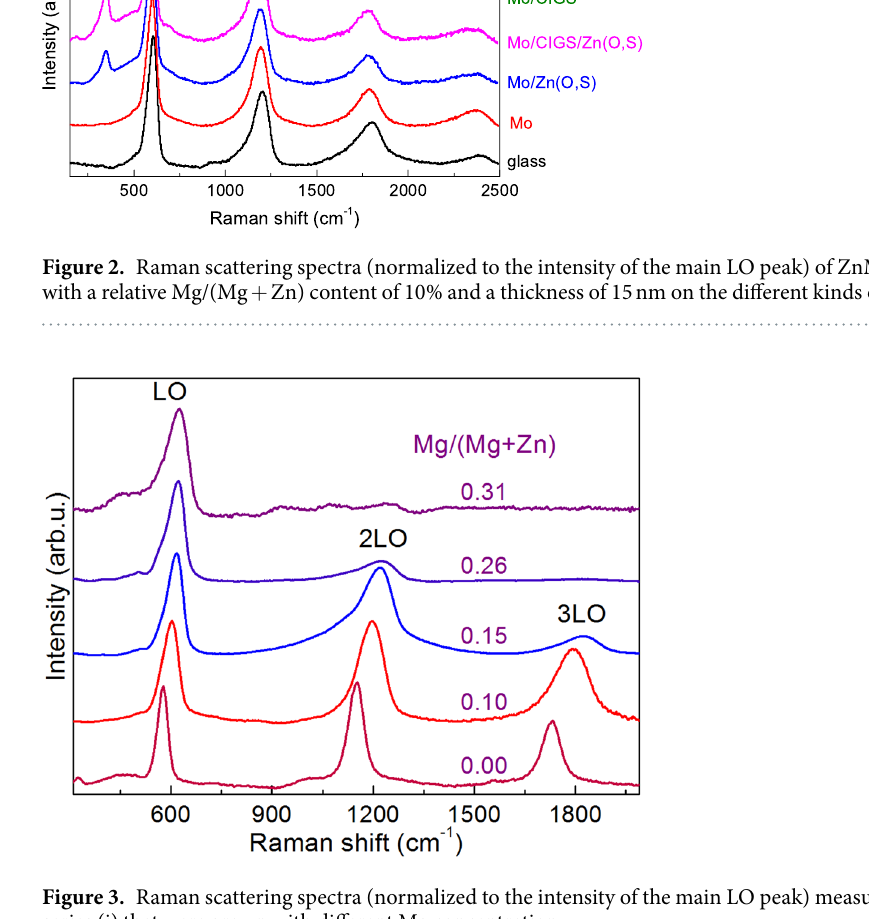
The LO peaks are also characterized by an asymmetric shape towards the lower frequency side, and this asymme- try increases with the Mg content in the alloy. This behaviour has been related to the presence of disorder effects leading to a relaxation of the selection rule at q = 0 and the activation of LO phonons with larger wavevector in the Brillouin zone, in agreement with refs 28 and 29. Figure 4 plots the relative Mg/(Mg + Zn) content ratio measured in these layers versus the frequency of the main LO peak in the Raman spectra. The figure includes also data previously reported in the literature 28, 30 , together with those derived from the analysis of the spectra shown in Fig. 3. All these data show the existence of a monotonous increase of the frequency of the LO mode with the Mg content in the alloy, which is related to the increase of the lattice constant with the Mg content. The dispersion between the different measurements in this figure is likely related to additional effects affecting the frequency of the Raman peaks as those induced by the presence of structural defects and/or strain. However, in spite of this, it is interesting to remark the good level of agreement of the majority of the experimental data, with only one point that shows a higher deviation. This con- firms the existence of a main dependence of the frequency of the LO Raman peak on the Mg content in the solid solution for the investigated composition range. The existence of a monotonous increase of the frequency of the LO peak with the Mg content has already been reported by Wei et al . 30 and Ye et al . 28 from the analysis of samples covering different ranges of compositions of the ZnMgO solid solution. These authors proposed linear empirical equations 30 or used a modified random element isodisplacement (MREI) model with a small bowing coefficient 28 . In contrast with the linear equation proposed in ref. 30, the data plotted in Fig. 4 confirm the existence of a clear bowing in the range of compositions 0 ≤ Mg/(Mg + Zn) ≤ 33%. The presence of this bowing could be related to the reduction of the effective mass of the solid solution. Figure 4 also shows the fitting of the experimental data with the following parabolic equation: